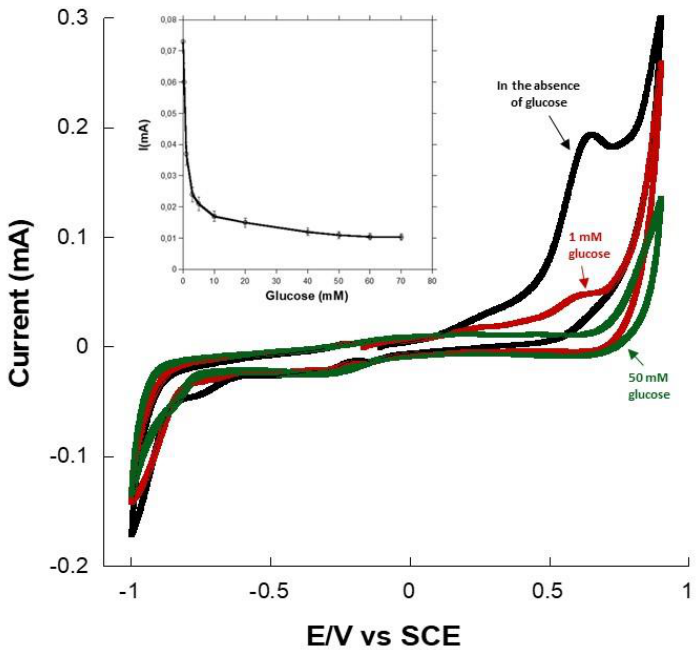
Figure 6. Cyclic voltammograms of the gold–PMG–ALDR–NADPH electrode at 2 mV · s − 1 examined in pH 7 PBS in the absence and the presence of 1- and 50-mM glucose. Inset, oxidation current at +0.62 V as a function of glucose concentration (3 repetitions).